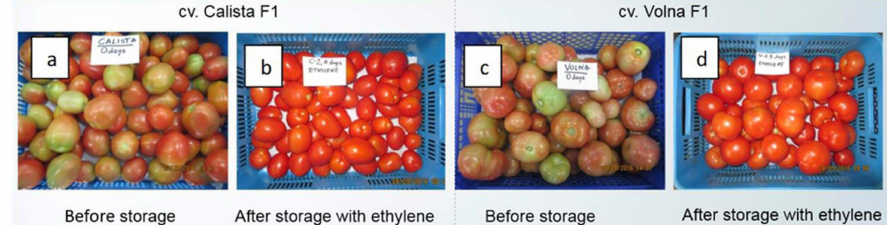
Figure 2. Example of ethylene treatment. Examples of Calista ( a ) and Volna ( c ) varieties that were not ripe at the time of harvesting and the respective varieties after six days of storage under ethylene atmosphere ( b , d ). Adapted from Grzegorzewska et al., 2017 [89], with permission.